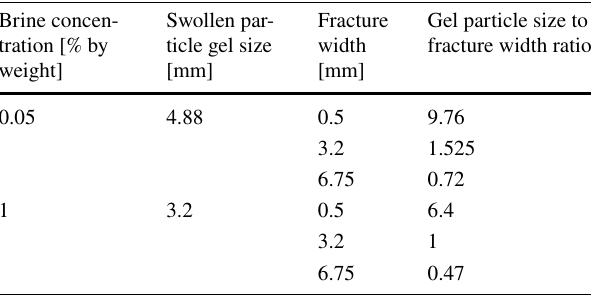
Table 2 Characteristics of the polymer gel particle/opening ratio parameters Brine concen- tration [% by